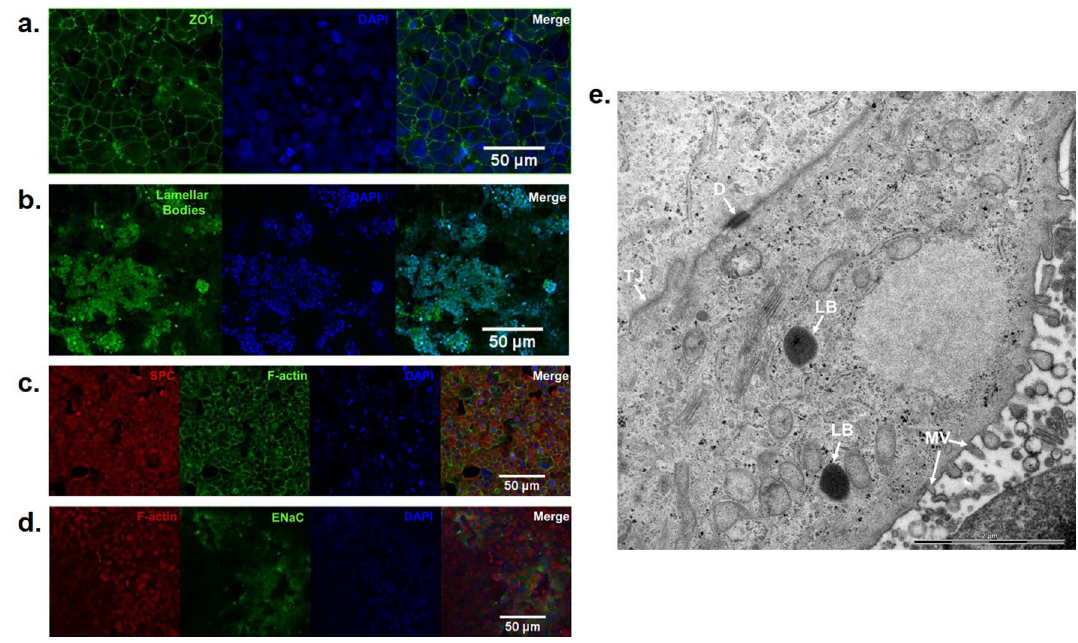
Figure 5. Morphological characterization of the alveolar mucosa model by confocal and transmission electron microscopy (TEM). ( a ) The cell junction protein zona occludin 1 (ZO1) ( b ) lamellar bodies, ( c ) surfactant protein C (SPC) and ( d ) epithelial sodium channel (ENaC). Nucleus is stained in blue. Bar scale: 50 µm; ( e ) Representative TEM image of the alveolar type II cells in air–liquid interface (2 weeks) showing microvilli (MV), lipid bodies (LB), desmosome (D), and tight junction (TJ) Bar scale: 2 µm. The microscopic images are representative of alveolar mucosa model developed at air–liquid interface (2 weeks) from NCl-H441